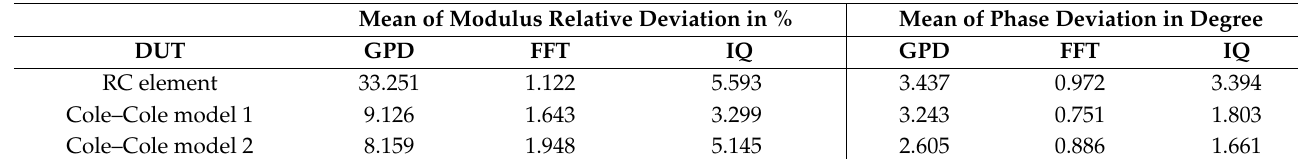
Table 1. Comparative study and deviation evaluation of tested DUTs.